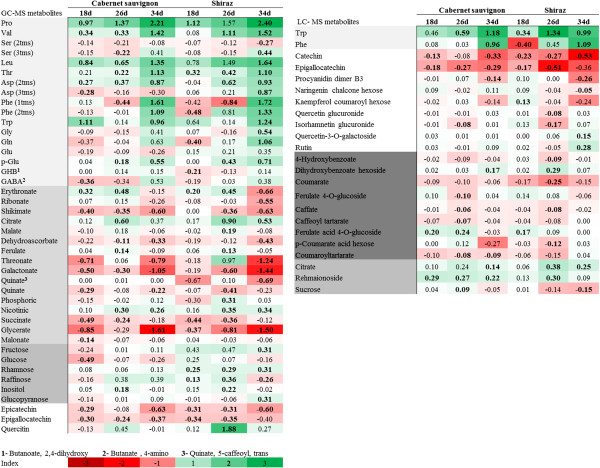
Metabolic responses to progressive water deficit in leaves of Cabernet Sauvignon and Shiraz. Values are the logarithmic transformed fold change (water deficit/irrigated) of selected leaf metabolites on days 18, 26, and 34 of the experiment. Bolded figures represent significant difference between irrigated and water deficit treatments as tested by the Student’s t-test (p-value < 0.05). Different colors represent the increase (green) or decrease (red) in metabolite logarithmic fold change as indicated in the color index (n = 6).